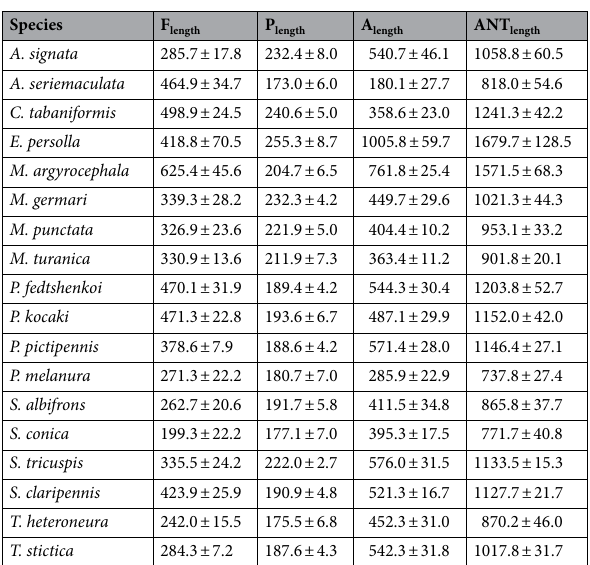
Table 2. Mean ± standard error of the four morphological variables associated with the antennal size, calculated across individuals for each species. All measures are in µm. F funiculus, P pedicel, A arista, ANT